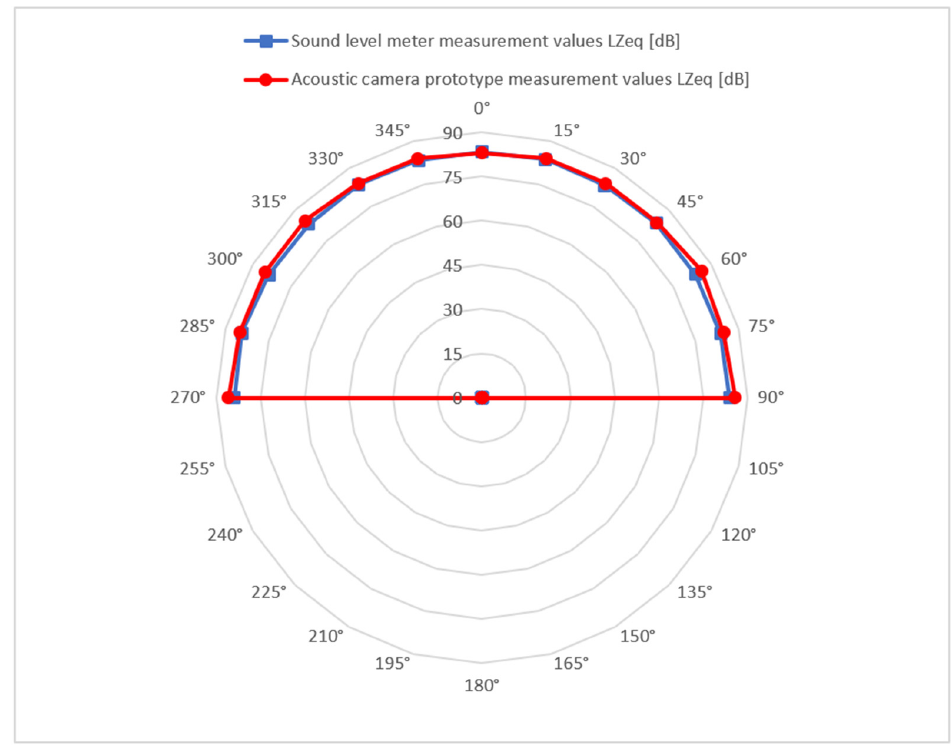
Figure 15. The comparison of the measured directional characteristic of the acoustic camera prototype (red colour) with the measured values obtained with the Brüel & Kjær 2250 sound meter (blue colour).